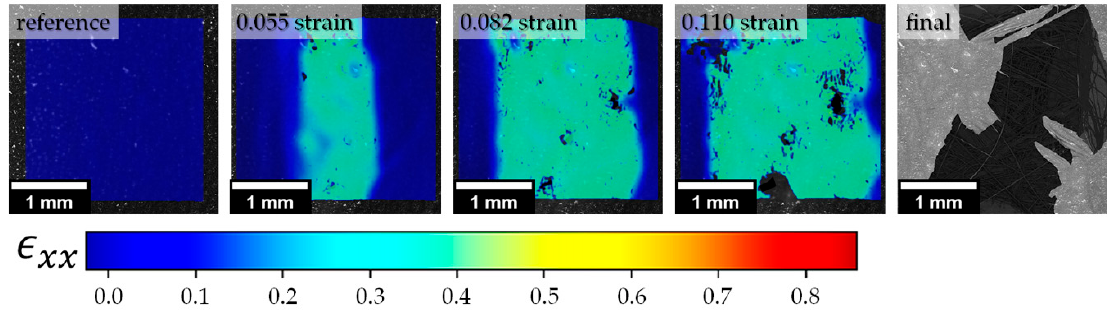
Figure 10. Typical strain localization and structure fluffiness observed by DIC and SEM, respectively, during in situ tensile test of SRCs with transverse fiber